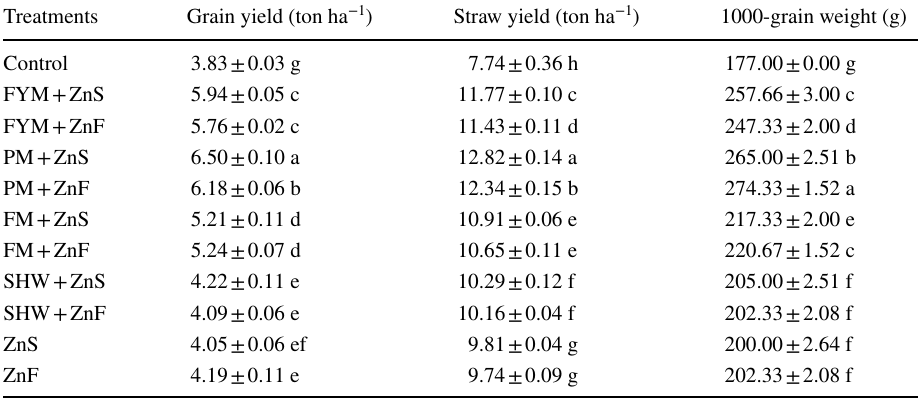
Different letters in the same column indicate significant differences by LSD at P ≤ 0.05 and ±